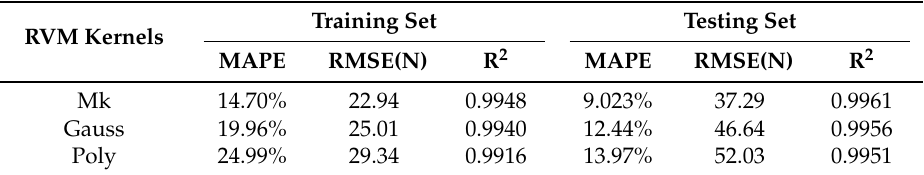
Figure 13. The comparison of correlation coefficient between measured Dp and predicted Dp from the MkRVM, GaussRVM and PolyRVM. Table 2. Comparison of the prediction performance of different kernel RVM